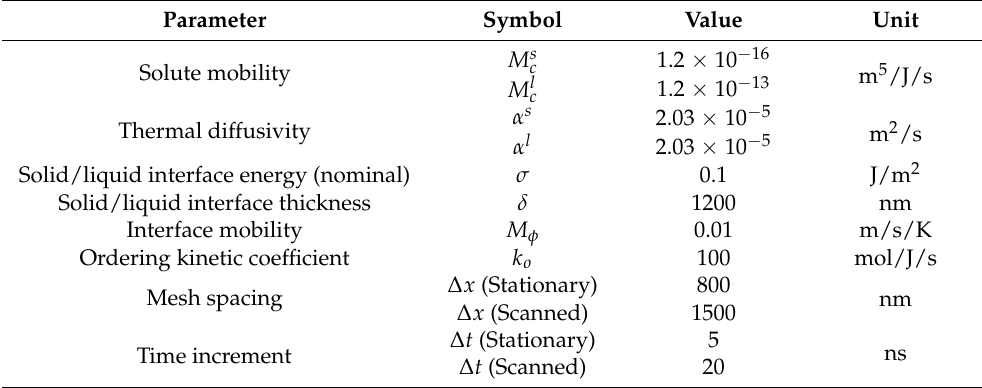
Table 3. Input parameters used for numerical simulations. Solute mobilities and thermal diffusivities are from Refs [30] and [38],